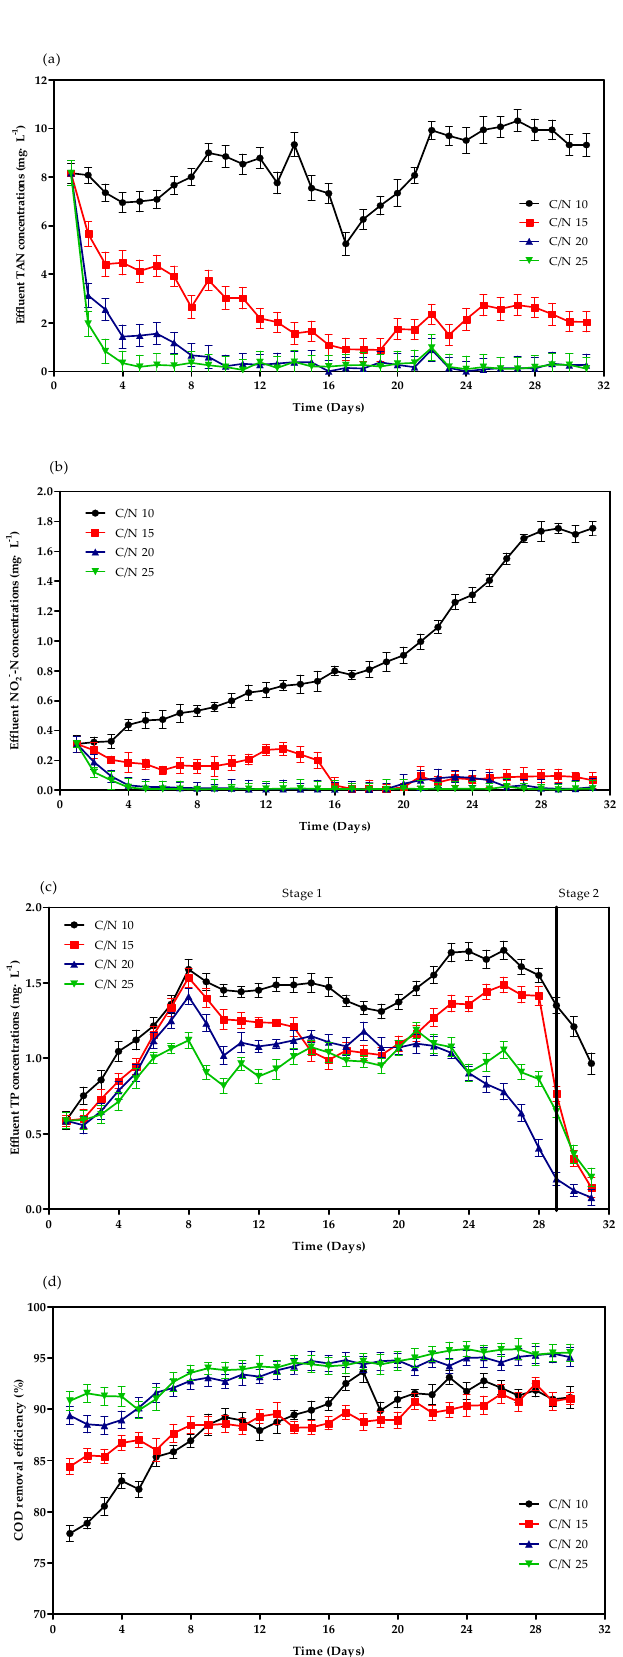
Figure 1. Changes in total ammonia nitrogen (TAN) ( a ); nitrite (NO 2 − -N) ( b ); total phosphorus (TP) ( c ); and COD removal efficiency ( d ) of the suspended growth bioreactors at different C/N ratio (mean ± stand deviation).